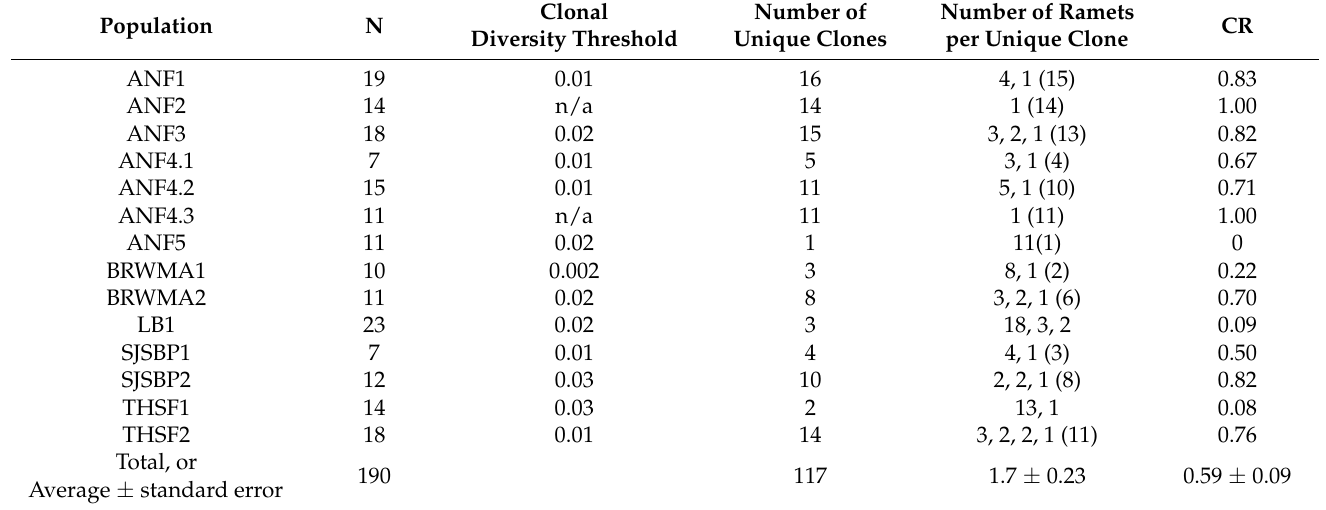
Table 2. Estimation of the number of unique clones (genotypes), ramets, and clonal richness per S. floridana population. N = sample size. Fifth column reports the number of ramets per